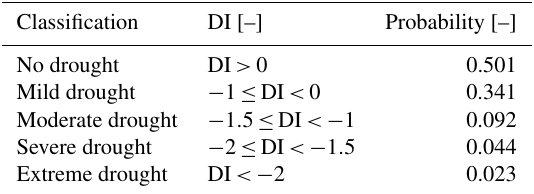
Table 3. Classification of standardized drought indices (DIs) used in this study (SPI, SPEI, and